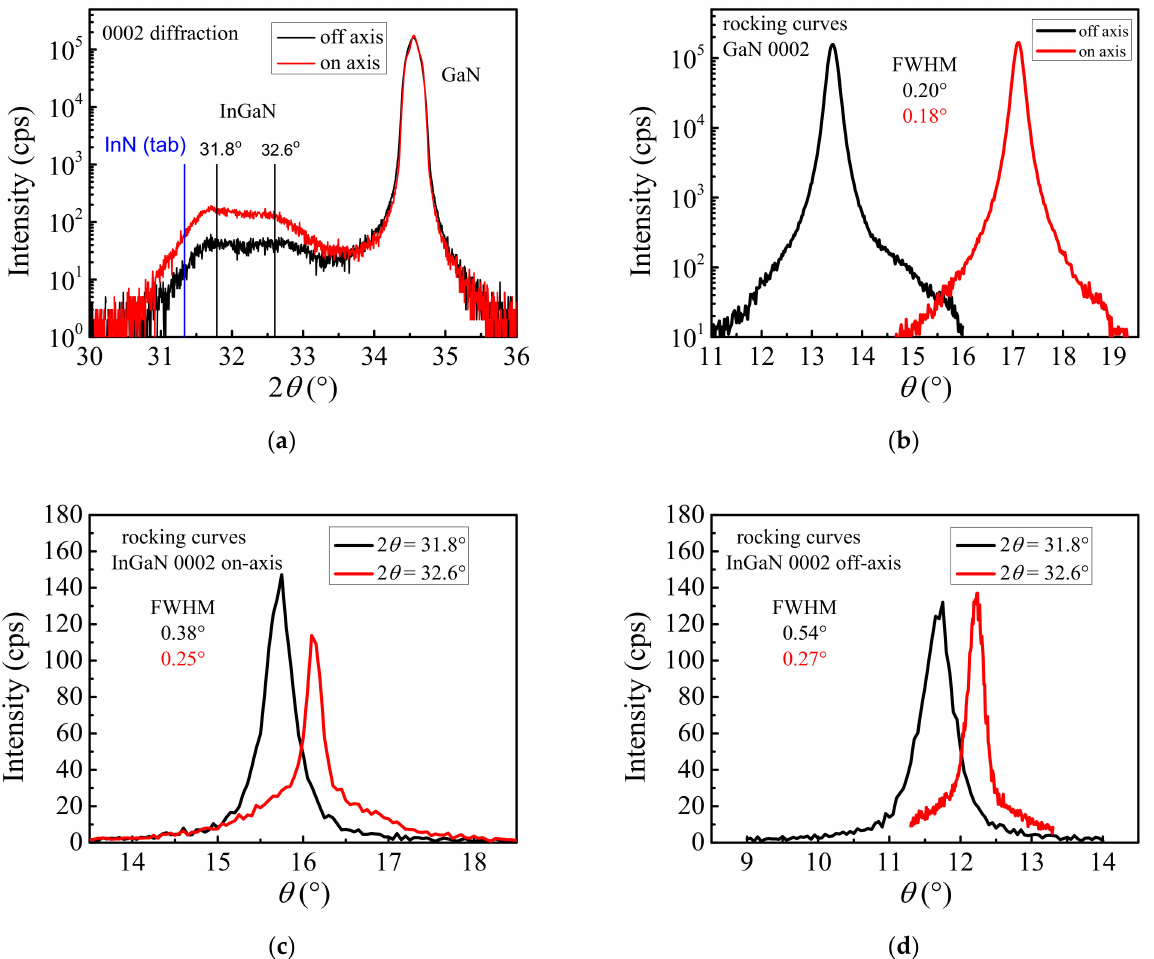
Figure 4. XRD 2 θ / ω -scan showing diffractions 0002 of GaN and In(Ga)N ( a ), corresponding rocking curves for GaN on the on-axis and off-axis samples ( b ) and rocking curves for two 0002 maxima of In(Ga)N measured on the on-axis ( c ) and off-axis ( d )